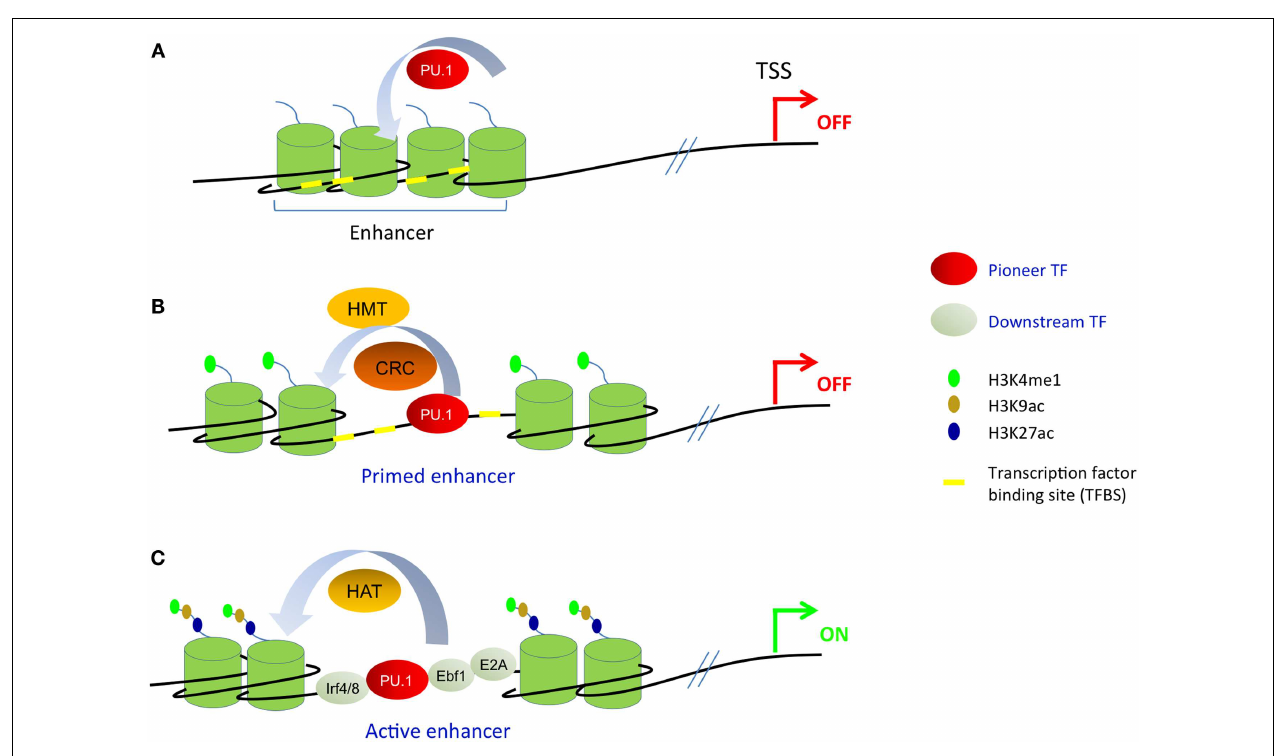
(B) Recruitment of histone methyltransferases (HMTs) and chromatin remodeling complexes (CRC) which prime the enhancer for subsequent